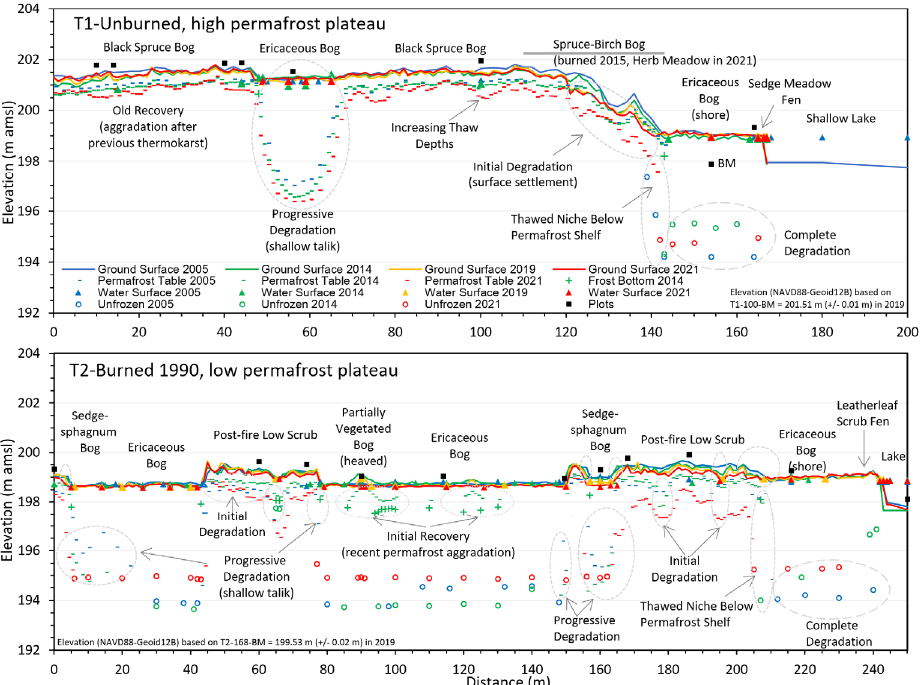
Figure 7. Cross-sectional profiles on an unburned, high permafrost plateau ( T1 ) and burned, low permafrost plateau ( T2 ) showing changes in the ground surface, permafrost table, and water surface from 2005 to 2021 in relation to ecotypes at Gosling Lake. Additionally shown are maximum unfrozen depths determined from probing and plot locations. Gray-dashed ellipses highlight areas where permafrost aggraded or degraded.